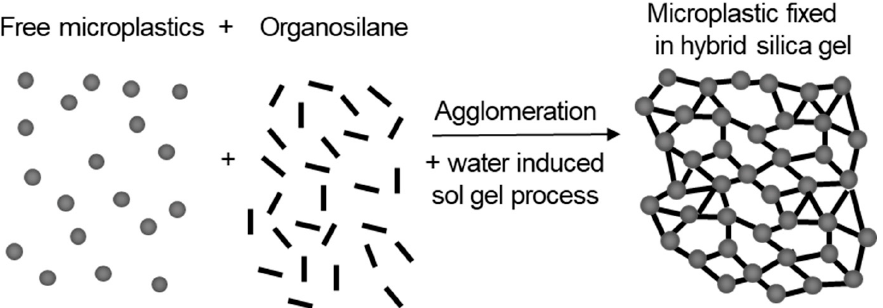
Figure 1. Agglomeration-fixation reaction: Removal of microplastics from water using organosilanes. Organosilanes attach to the surface of microplastics, collect it in large agglomerates and chemically fix it by forming a solid hybrid silica in a water induced sol ‐ gel process.